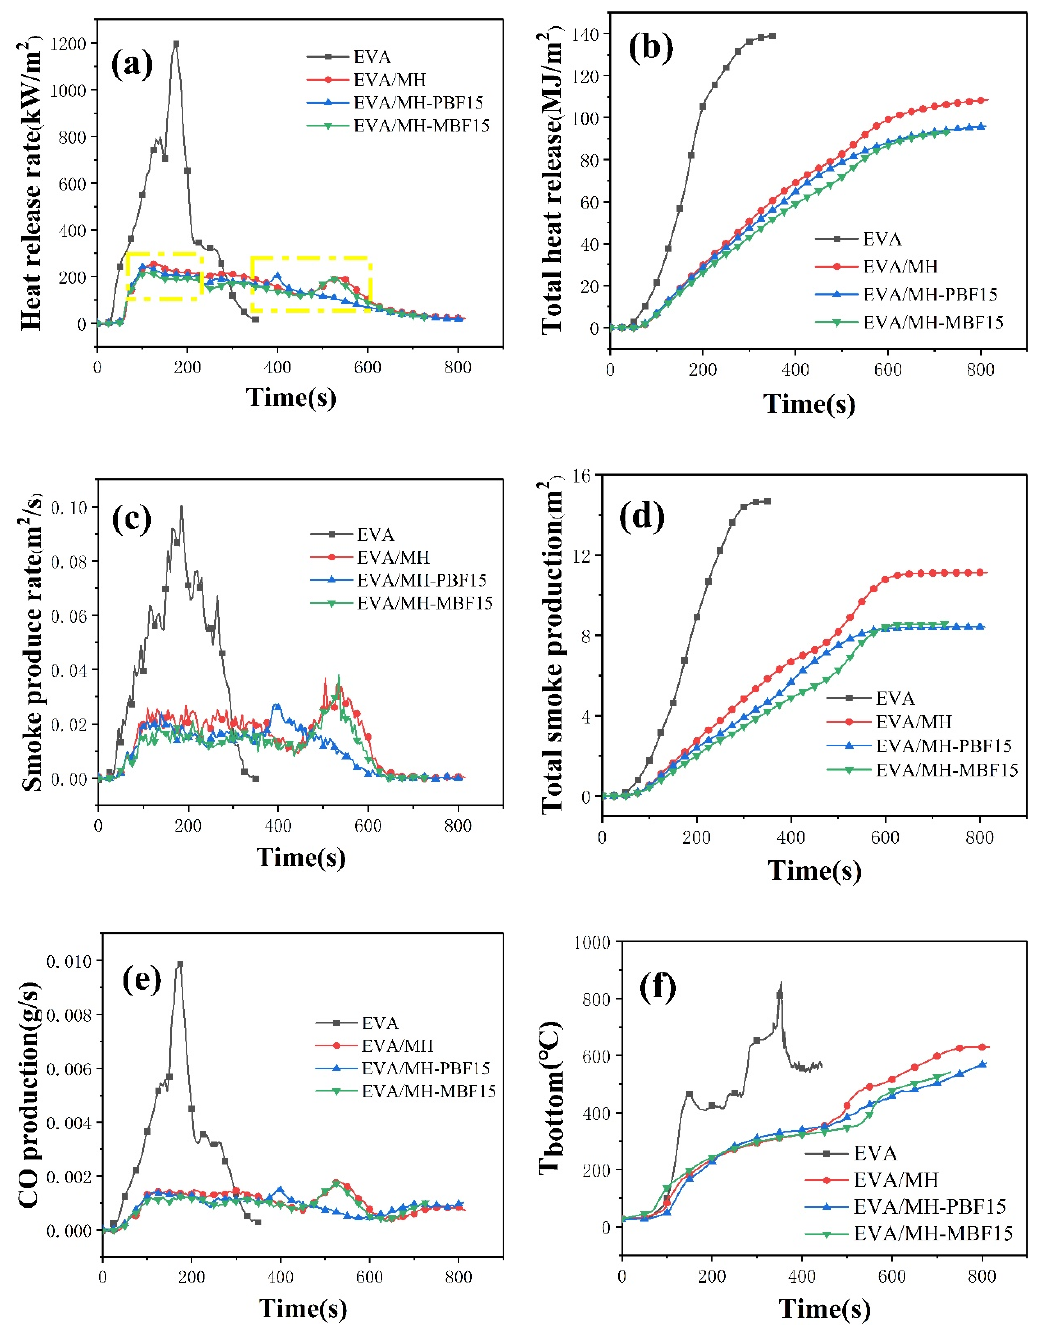
Figure 5. ( a ) heat release rate (HRR), ( b ) total heat release (THR), ( c ) smoke produce rate (SPR), ( d ) total smoke production (TSP), ( e ) CO production rate (COP), ( f ) bottom temperature value of EVA and EVA / MH-BF Table 2. CCT Data of EVA and EVA Composites.